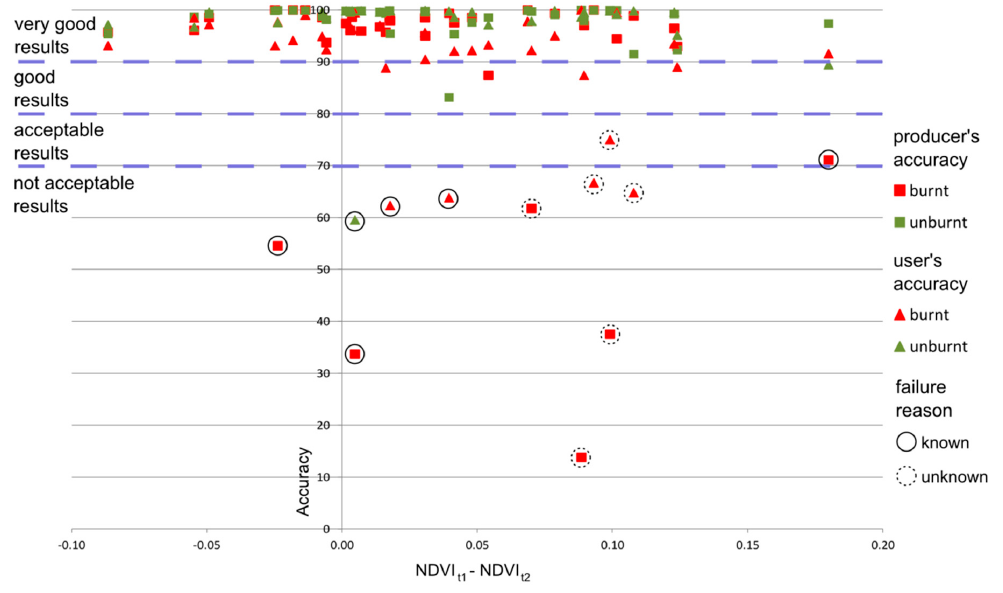
Figure 5. Relationship between scene difference and threshold for burnt and unburnt areas delimitation.